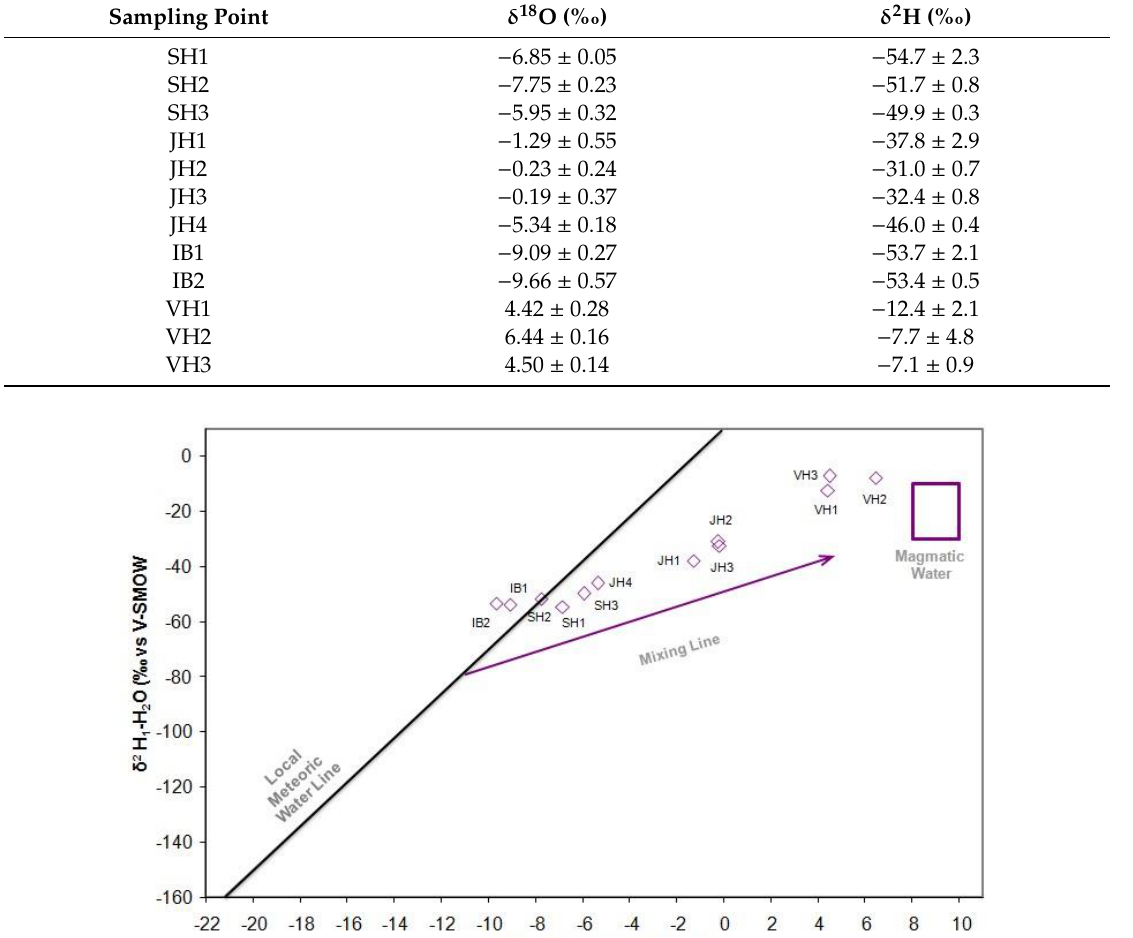
Table 10. Value of δ 1 8O and δ 2 H stable isotopes.